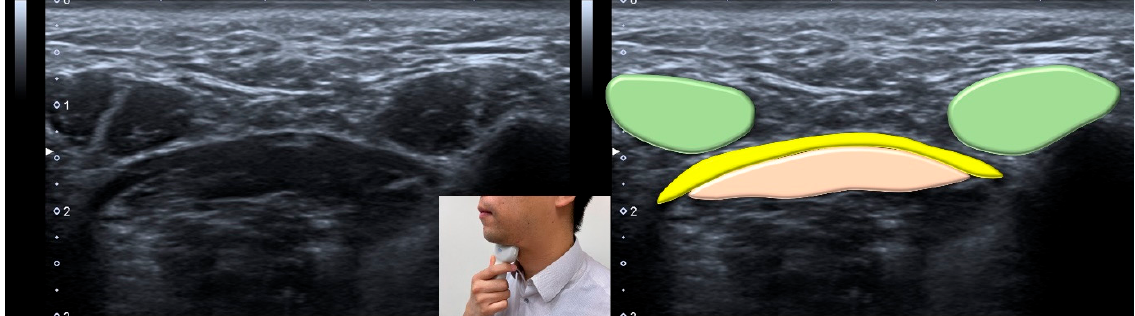
Figure 7. Ultrasonographic images and schematic drawing of the anterior belly of the digastric muscle in the coronal plane. Digastric muscle, green color block; mylohyoid muscle, yellow color block; geniohyoid muscle, pink color block.